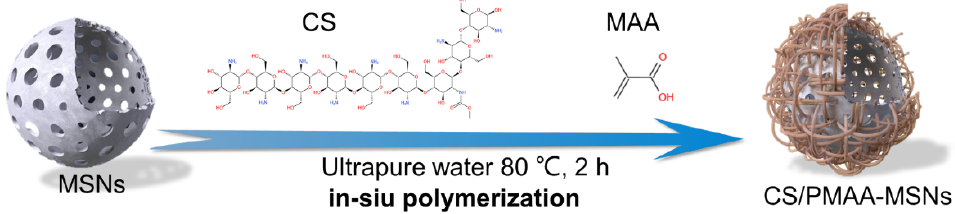
Figure 3. Synthesis mechanism of pH-responsive polymer shell chitosan/poly (methacrylic acid) (CS-PMAA) coating on mesoporous silica nanoparticles